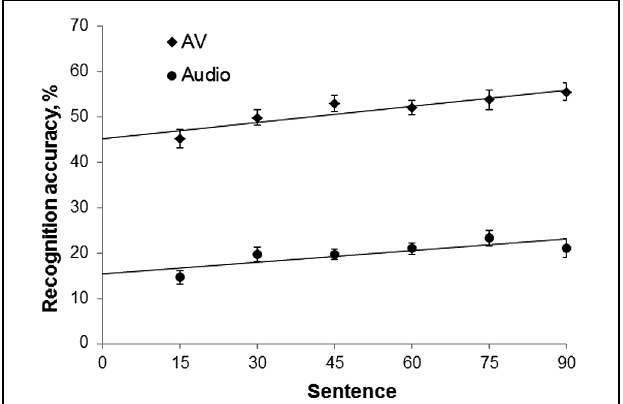
FIGURE 5 | Mean % recognition accuracy of accented speech in Study 2, per 15 sentences, per group, with linear fit. Error bars represent ± 1 SE. AV, audiovisual; Audio,